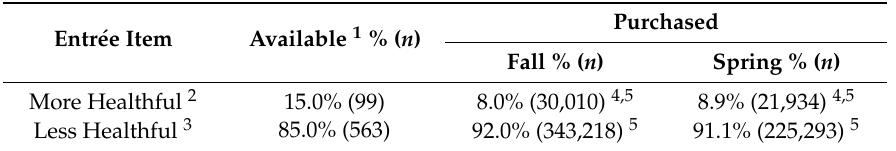
Table 2. More and less healthful entr é e items available and